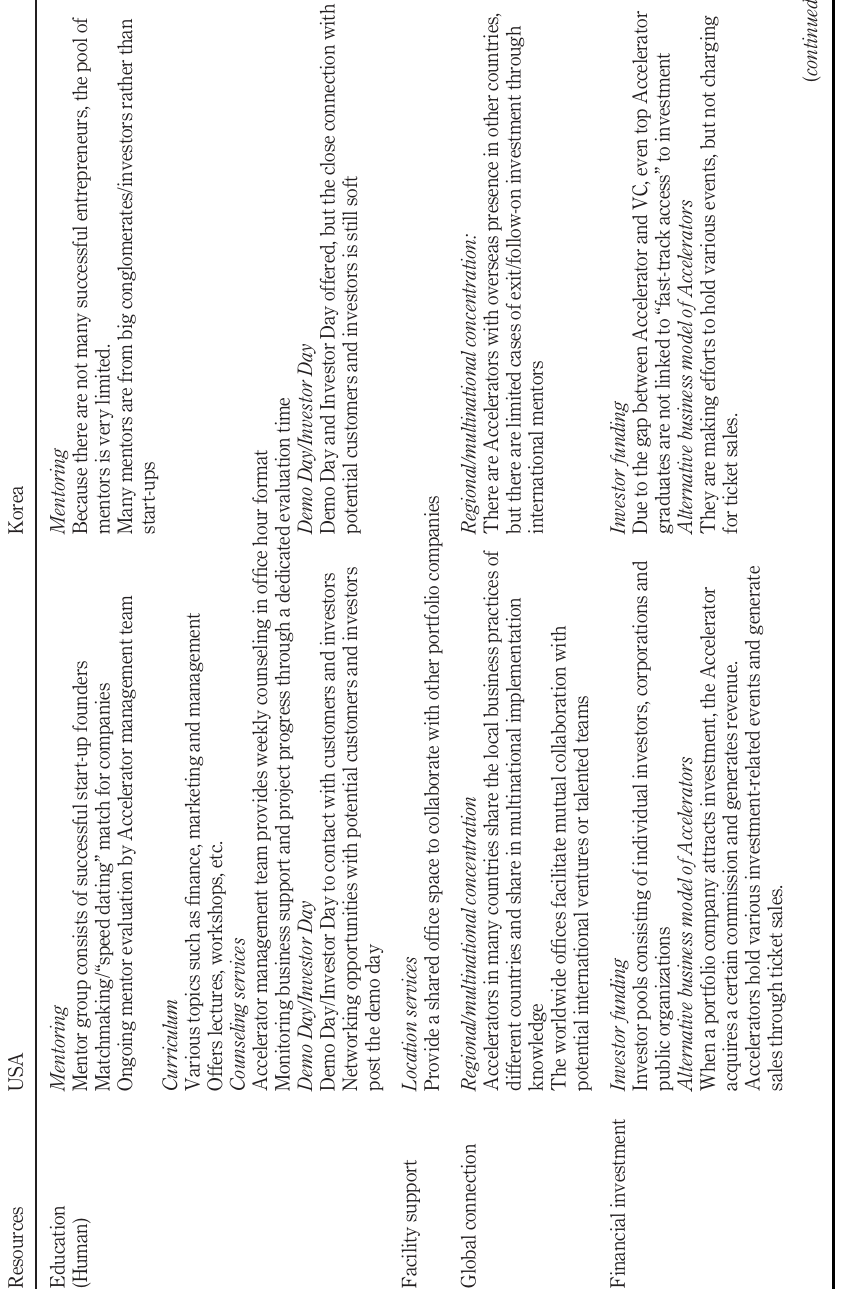
accelerators from resources-based